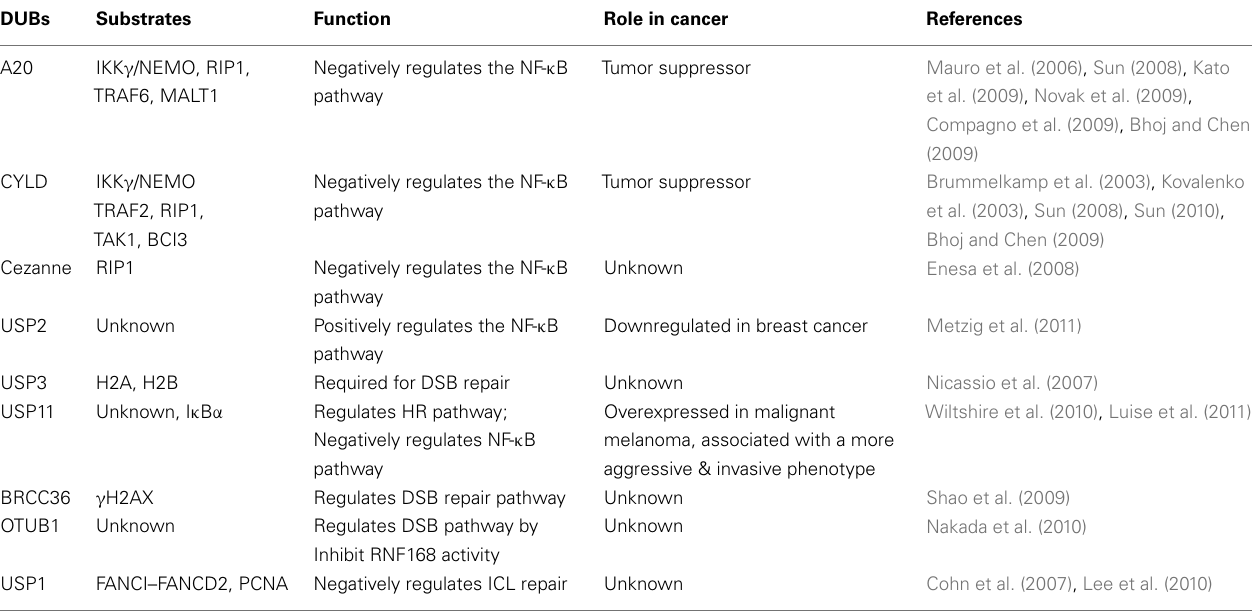
Table 1 | Deubiquitinating enzymes (DUBs) play important roles in NF- κ B activation, DNA damage response, and